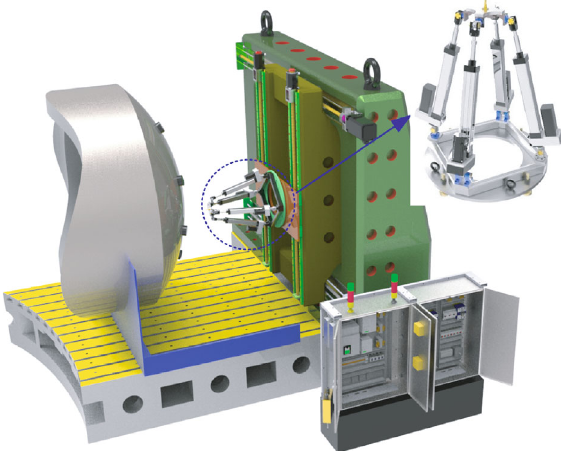
Figure 1: A fi ve-axis hybrid kinematic machine